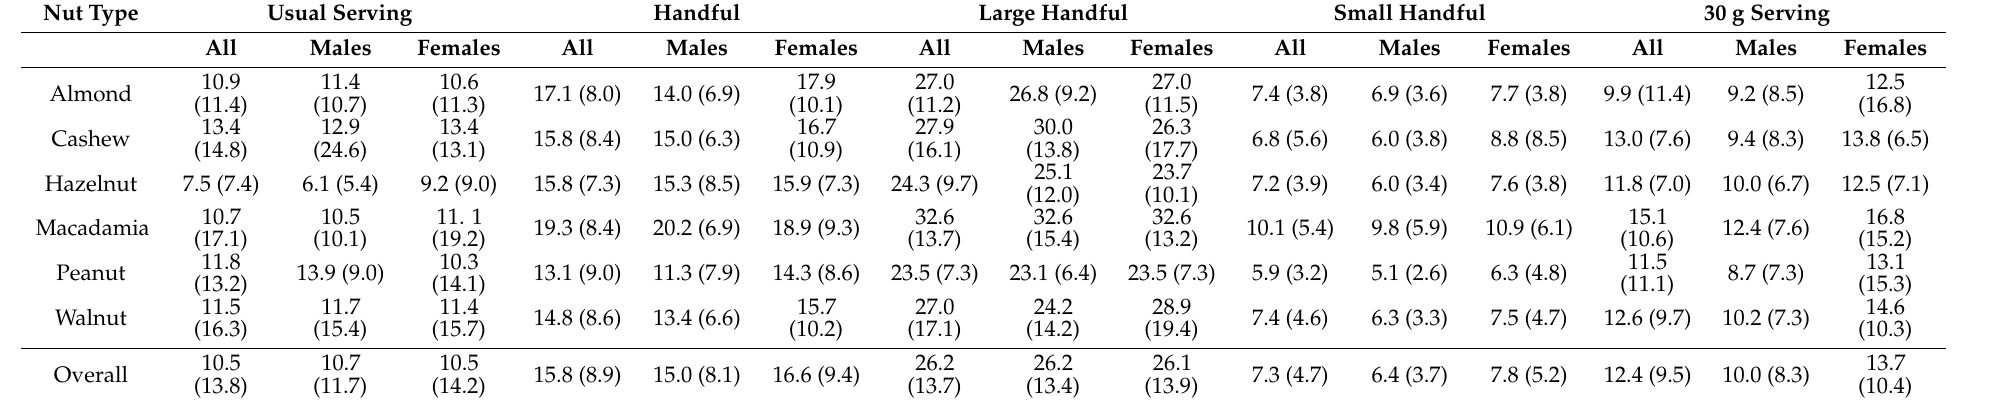
Table 4. Median (IQR) estimated percentage of total energy requirements provided from nuts with selection of the different portion